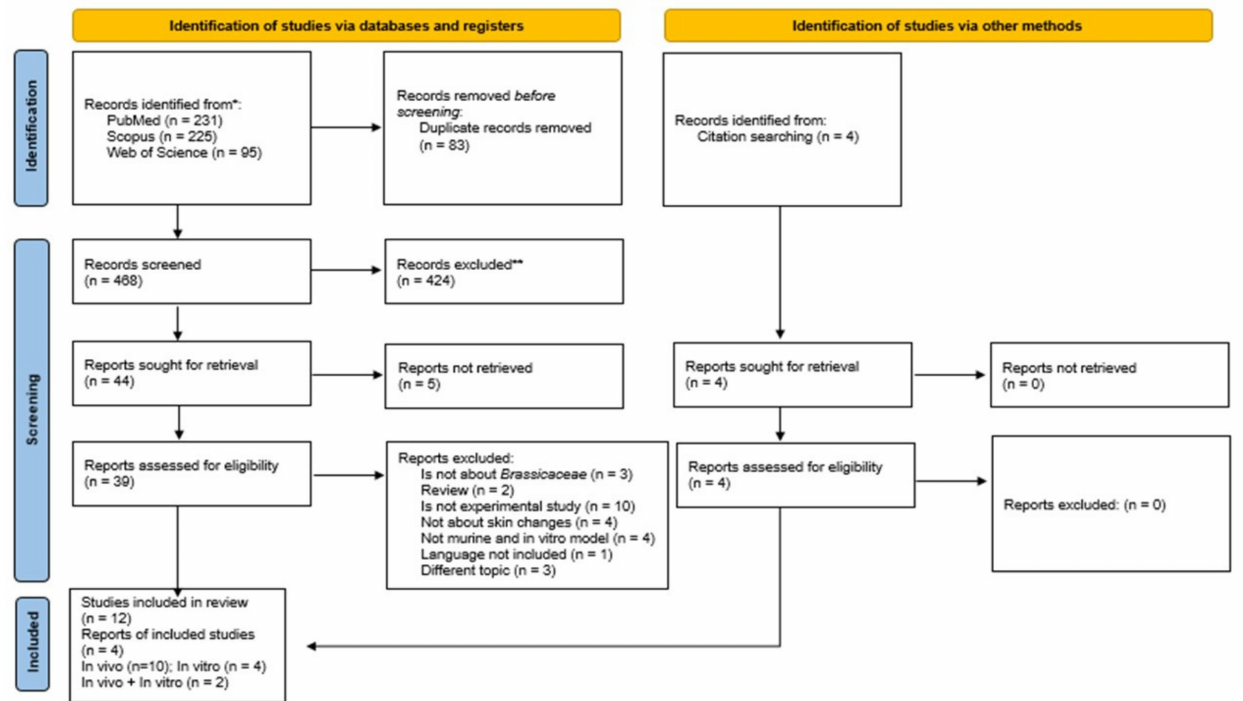
Figure 1. Preferred Reporting Items for Systematic Reviews and Meta-Analyses (PRISMA) flow diagram. The flowchart indicates the research records obtained at all standardized stages of the search process required for the development of systematic reviews and meta-analyses. Based on the PRISMA statement (http://www.prisma-statement.org, accessed on 25 June 2022). * Consider, if feasible to do so, reporting the number of records identified from each database or register searched (rather than the total number across all databases/registers). ** If automation tools were used, indicate how many records were excluded by a human and how many were excluded by automation